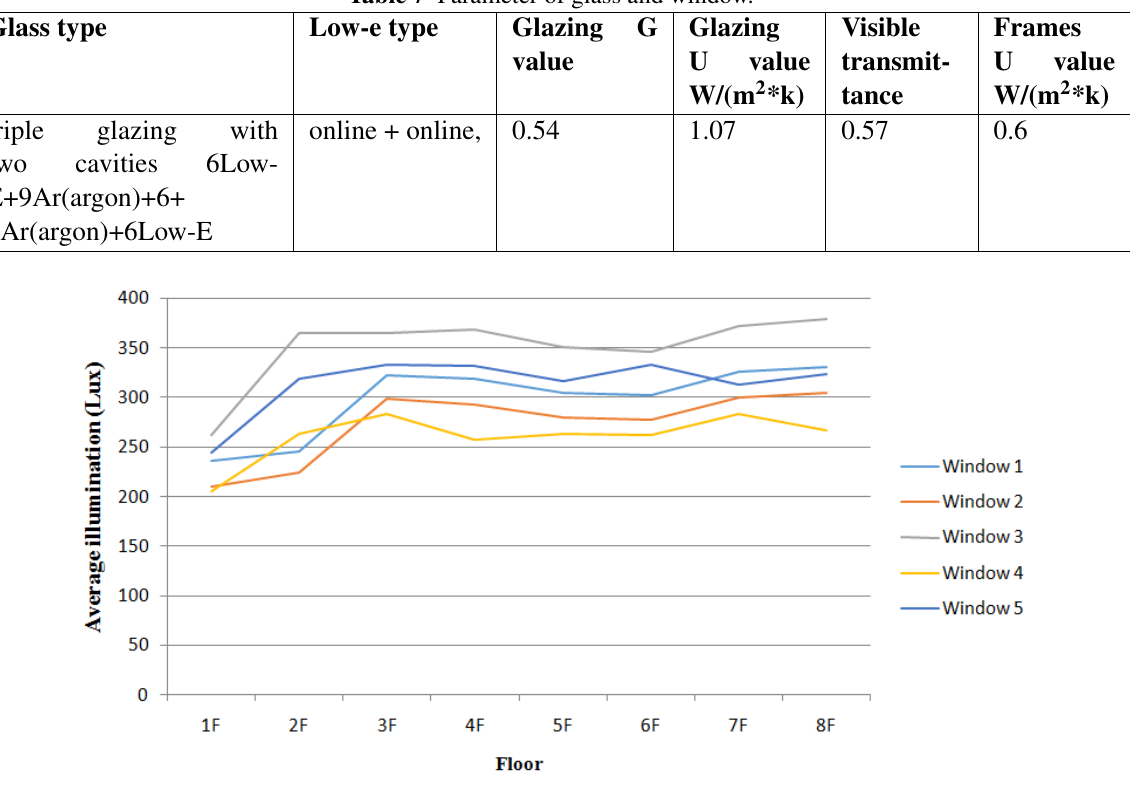
Fig. 9 Comparison of illumination of each floor.